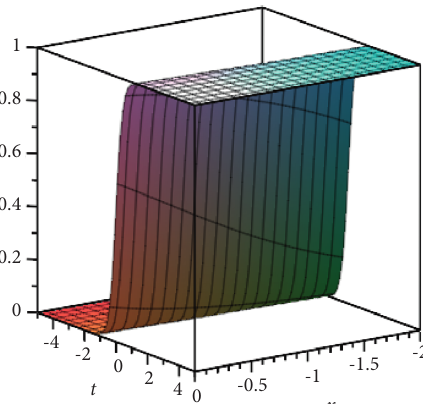
Figure 7: The antikink soliton solution of | q